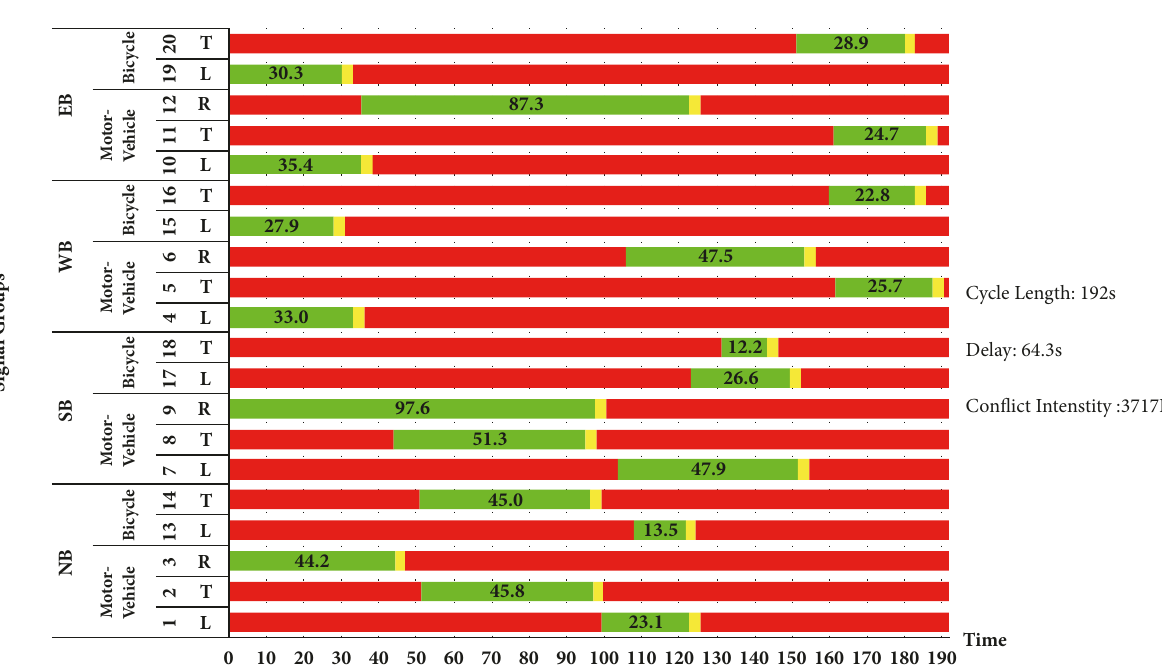
Figure 6: Optimal singal setting from one of the